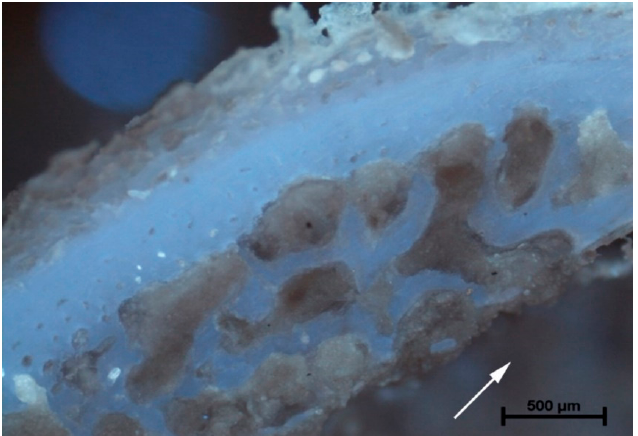
Figure 5. Rotation of 1200 rpm (3 °C). Total destruction of bone tissue and bone marrow. Visible empty bone marrow cavity (arrow) clearly distinguished from other parts of unchanged rib tissue.